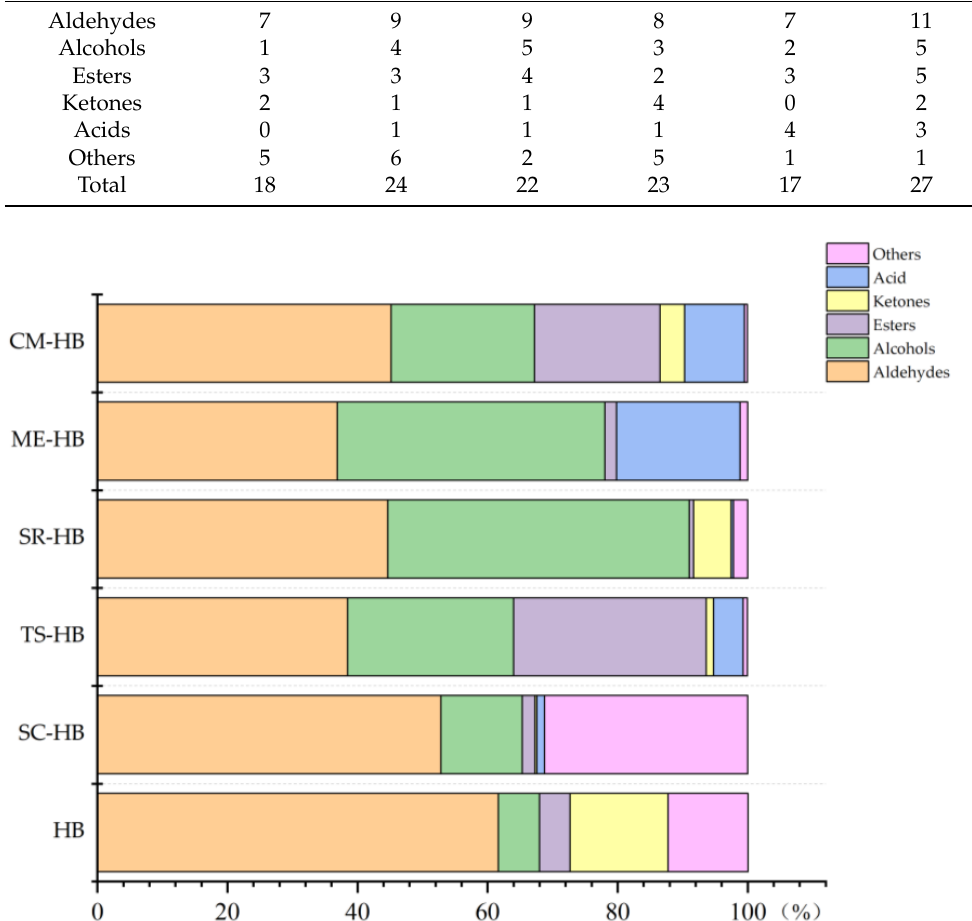
Figure 3. Changes in the total amount and types of volatile compounds in original and fermented highland barley samples: HB (original highland barley), CM-HB (fermented highland barley with C. militaris ), SR-HB (fermented highland barley with S. rugoso-annulata ), ME-HB (fermented highland barley with M. esculenta ), SC-HB (fermented highland barley with S. commune ), TS-HB (fermented highland barley with T. sanguinea ).